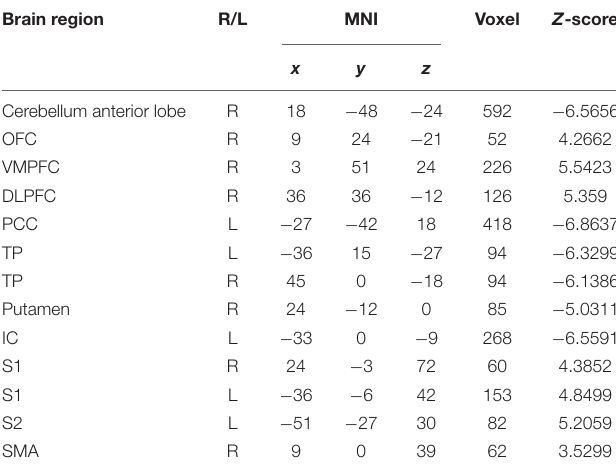
TABLE 6 | Summary of the brain regions indicating functional connectivity with the rACC in nocebo response in female participants ( p < 0.05, FDR < 0.05). Brain region R/L MNI Voxel Z -score